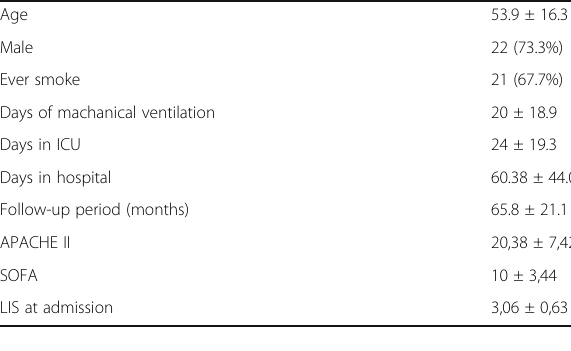
Table 76 (abstract A237). Demographics and clinical data